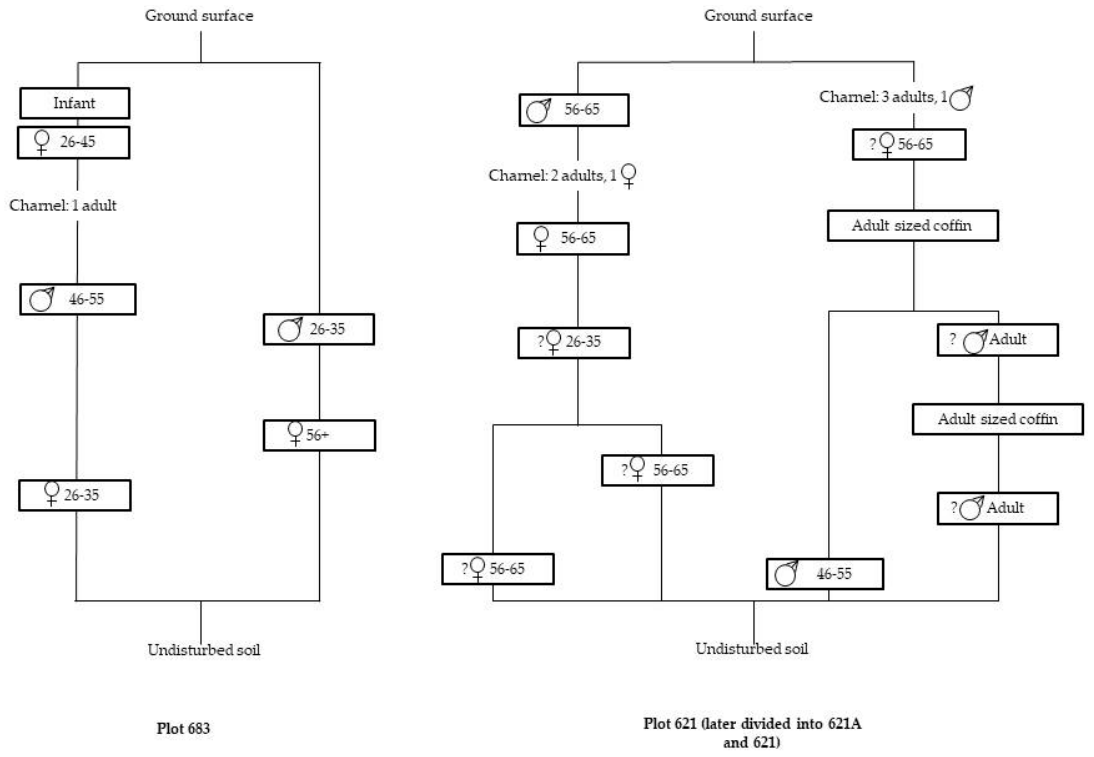
Figure 4. Archaeological genealogy: excavated graves and charnel deposits of bones within both of the Mønster family plots. Osteologically assessed adult age is expressed in grouped categories, osteologically assessed sex with a ‘?’ denotes unclear, or mixed morphological features in the skeleton.